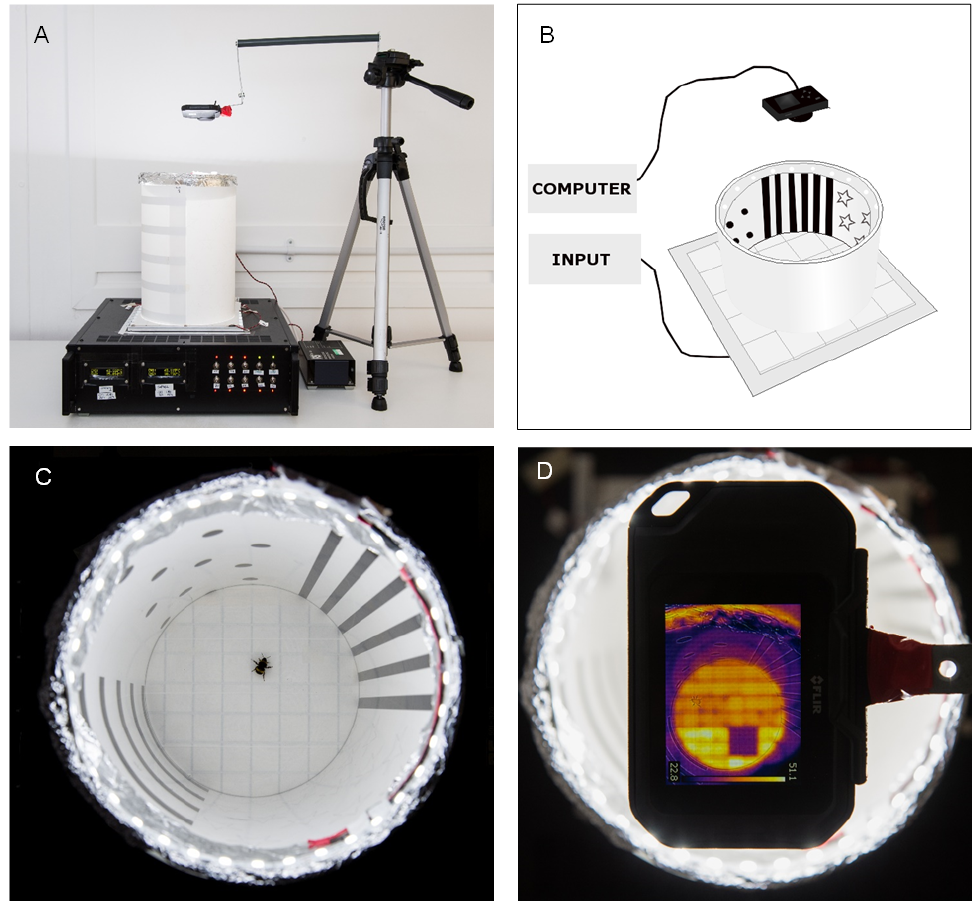
Figure 1. Taken from James et al. [2]; The thermal–visual arena. ( A , B ) Arena set up, with thermal imaging camera placed above the arena. ( C ) Birds-eye view of the arena displaying circumference and patterns. ( D ) Thermal image of the reward platform, showing the cool reward zone tiles (in purple).